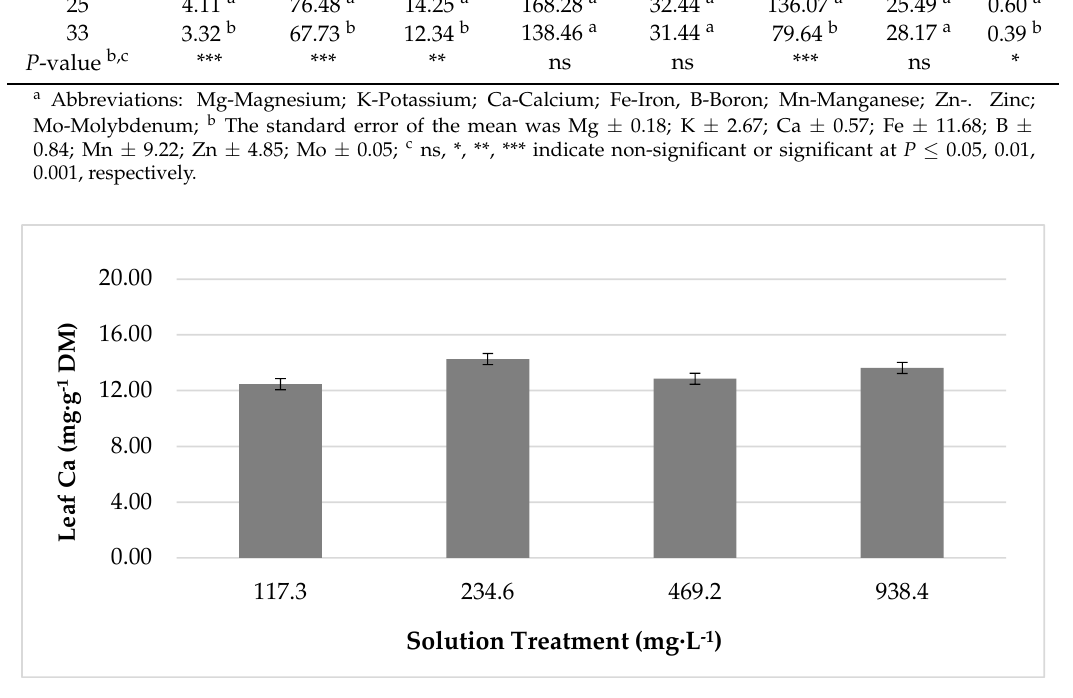
Figure 3. The effect of increasing potassium concentration of growth chamber produced, red ‘Lollo’ lettuce calcium concentration. The standard error of the mean was: Calcium ± 0.66.